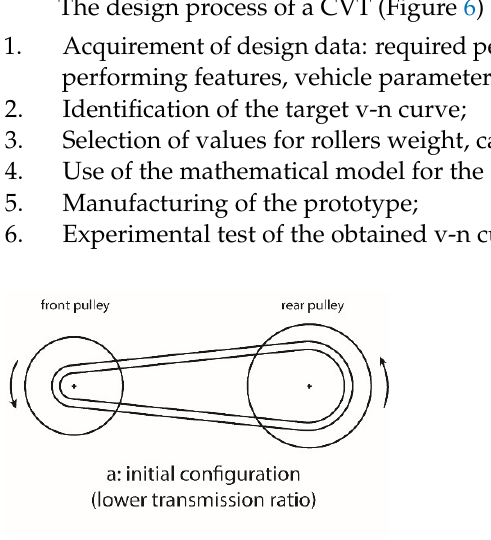
Figure 4. Front assembly configurations: initial/starting ( a ), intermediate ( b ), final ( c ).